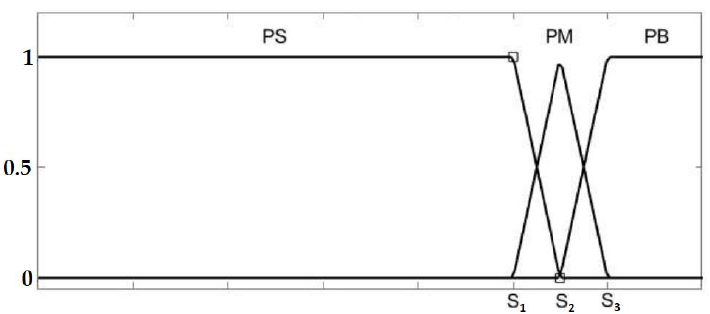
Figure 7. Fuzzy control membership functions for deviation in generator speed.